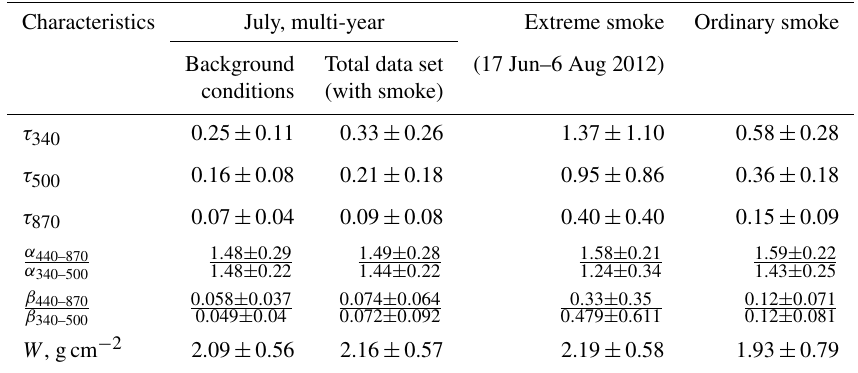
Table 1. Average ( ± SD) characteristics of AOD and water vapour content of the atmosphere during the period of extreme smoke in